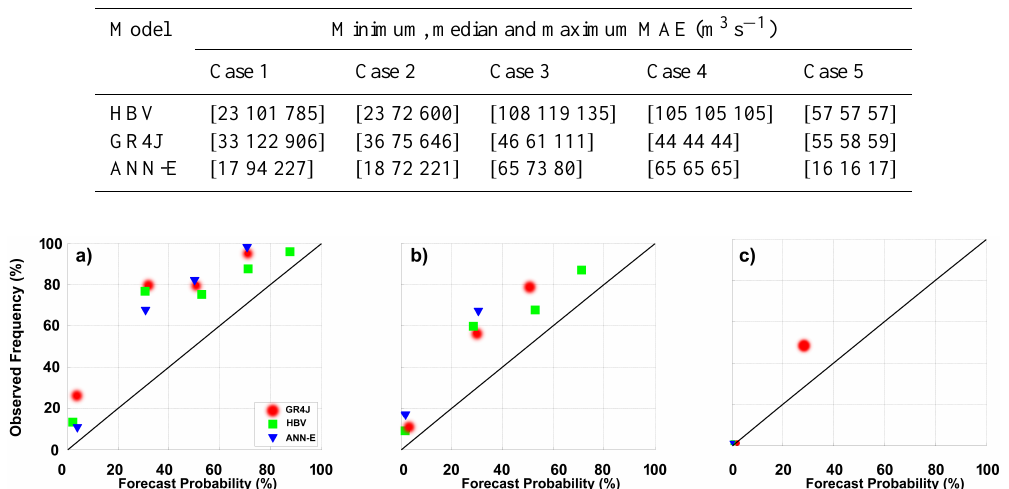
Figure 8. Reliability diagram for different low-flow forecasts. (a) Low flows below Q 75 threshold (584 observed events in the test period 2002–2005). (b) Low flows below Q 90 threshold (250 observed events). (c) Low flows below Q 99 threshold (20 observed events). The forecasts are issued for a lead time of 90 days for the test period 2002–2005 using ensemble P and PET as input for GR4J, HBV and ANN-E